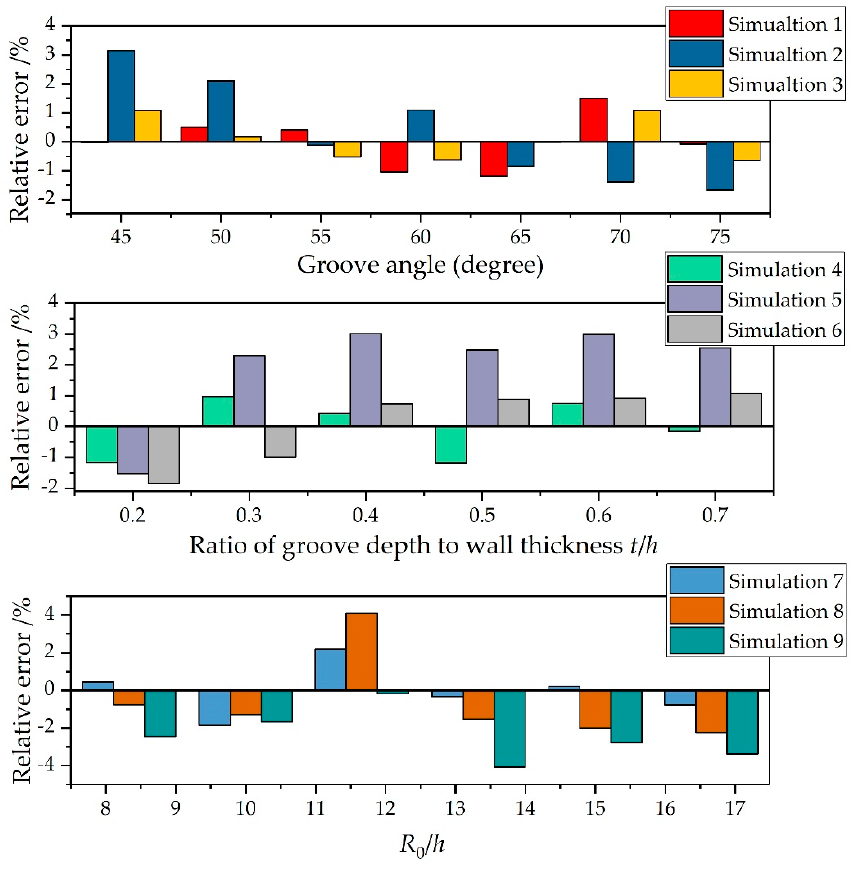
Figure 15. The relative error between the predictions from Equation (21) and the simulation re- sults.